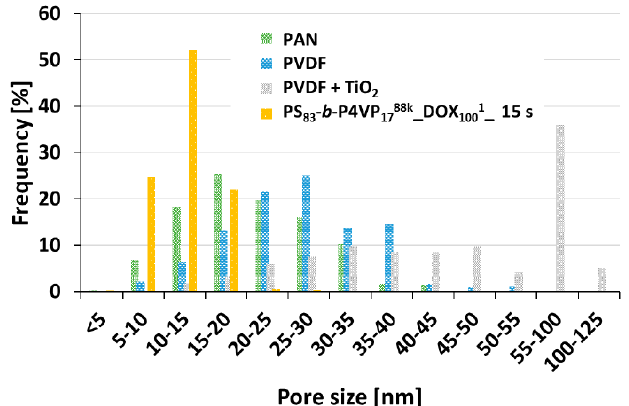
Figure A2. Pore size distribution measured by software on SEM images of different support membranes (PAN, PVDF and PVDF + TiO 2 (8 wt.%)) and a PS 83 - b -P4VP 1788k _DOX 1001 on PAN membrane with 15 s evaporation time.